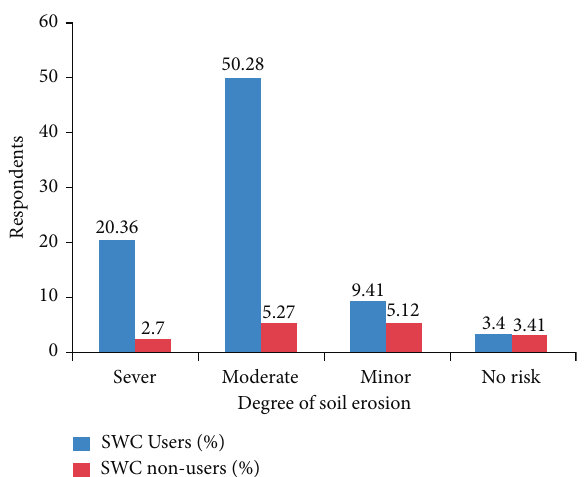
Figure 2: Farmers’ perception on the severity of soil erosion in the study area ( n �